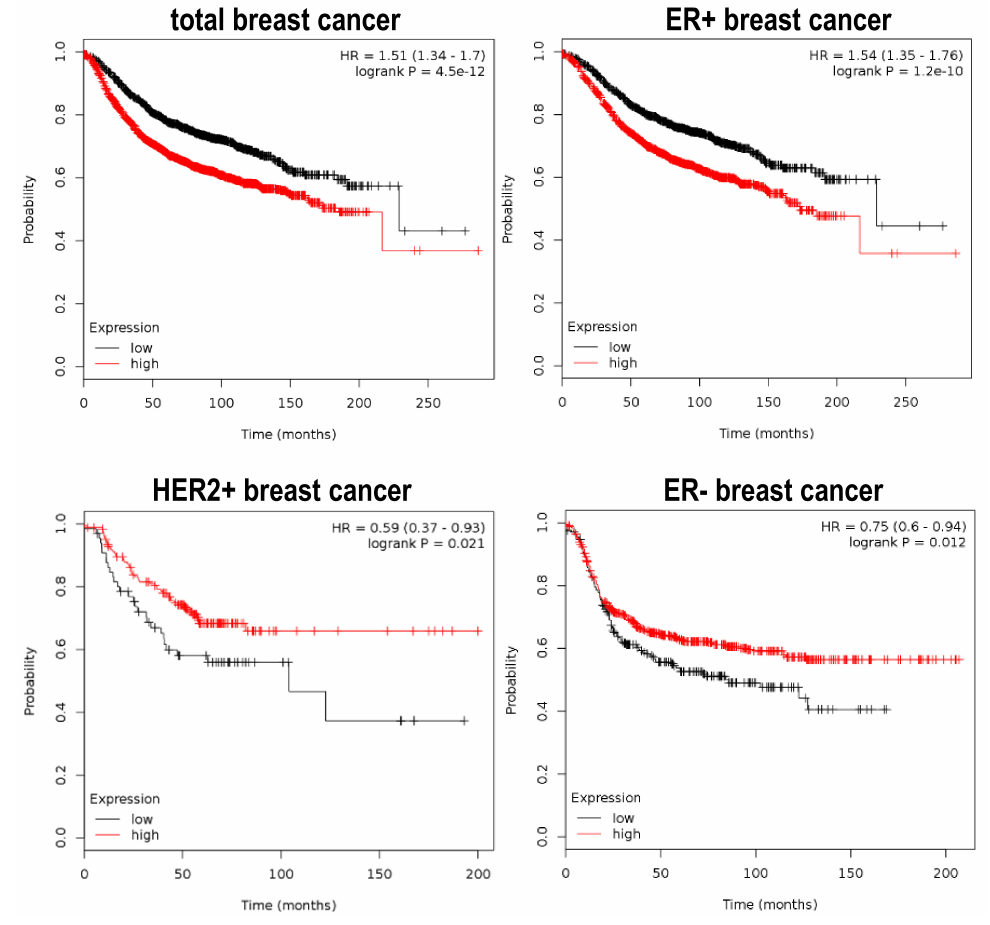
Figure 3. Differential prognostic value of Plk1 expression in breast tumor cancer. Plots depict the Relapse-Free Survival (RFS) ratio of different subtypes of breast cancer patients. Data is retrieved from the Kaplan Meier plotter initiative (www.kmplot.com), showing that Plk1 overexpressing tumors (red line) have a poor outcome in the estrogen ER+ subtype (n = 3951 samples) and total breast cancer tumors (n = 3951 samples). Conversely, ER − (n = 869 samples) and Her2+ (n = 252 samples) breast cancer patients, that express higher levels of Plk1 (red line), have better RFS ratios when compared to negative Plk1 tumors (black